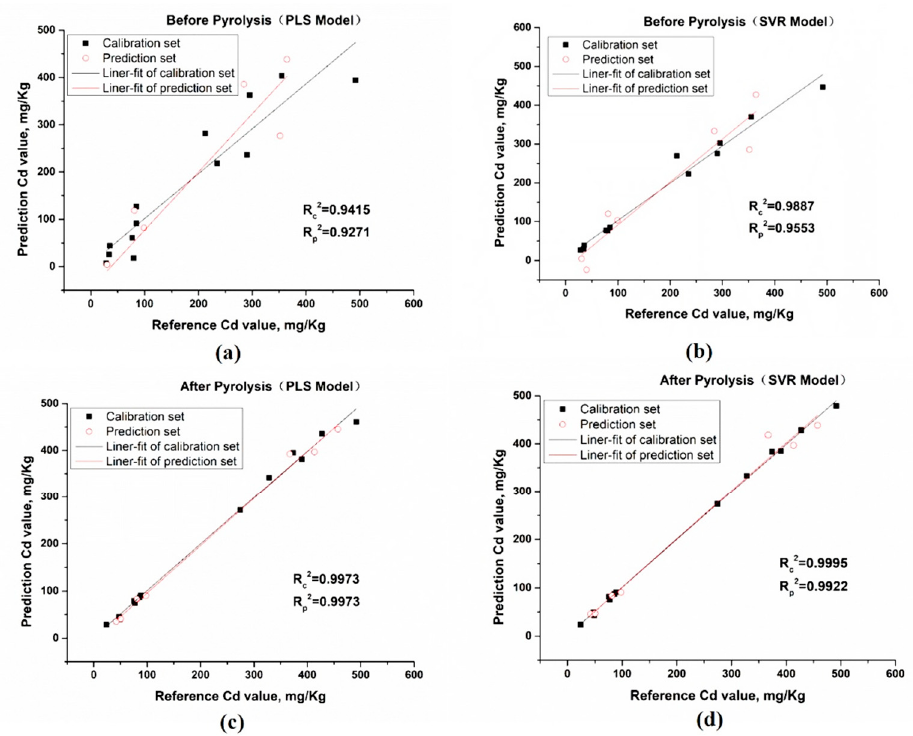
Figure 4. PLS model and SVR model. The PLS model before pyrolysis without preprocess ( a ) and SVR model before pyrolysis without preprocess ( b ); the PLS model after pyrolysis without preprocess ( c ) and SVR model after pyrolysis without preprocess ( d ).